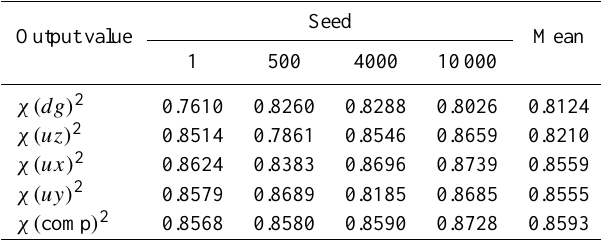
Table 3. Nonnormalized E-FAST TSIs for the five defined output parameters with respect to the height component ζ with 4 different seeds (1, 500, 4000, 10000) and the mean TSIs of 30 executions (the standard deviation see Table 6 row